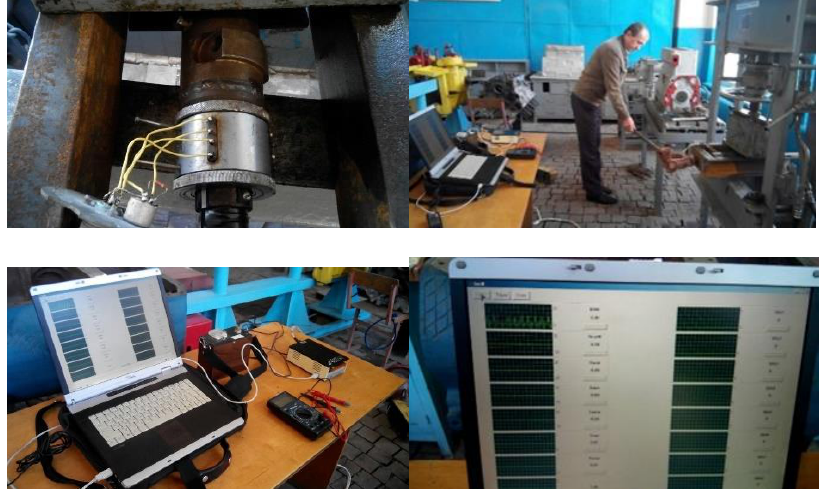
Figure 5. Calibration of mercury amalgamated current collector.